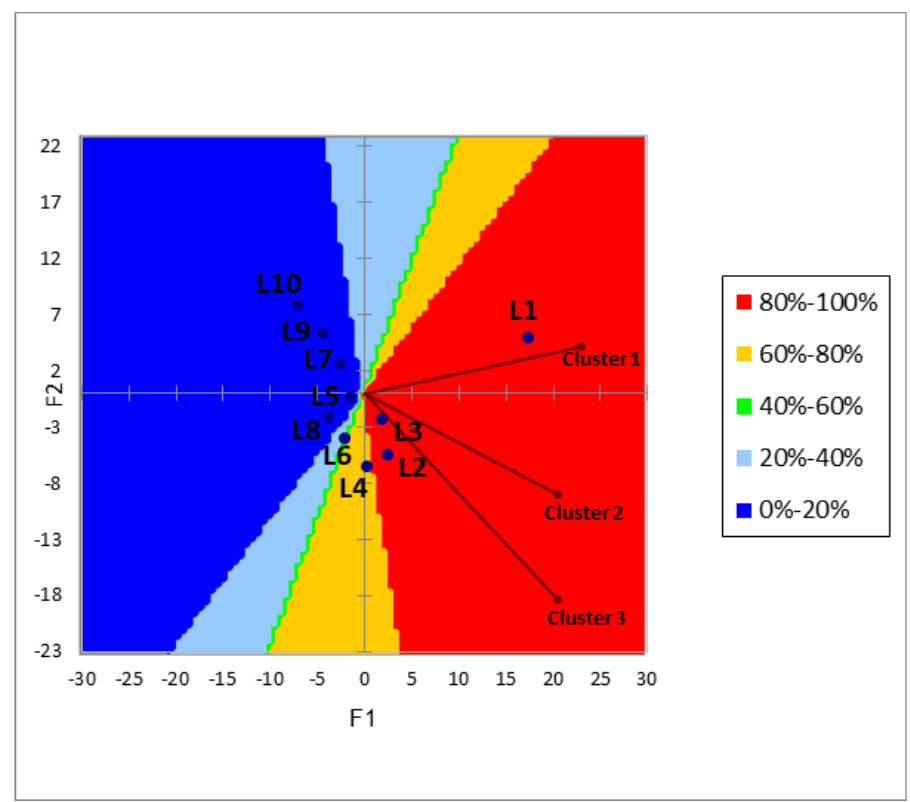
Figure 5. Preference map of consumers clusters and contour plot of preference for yogurt labels (Blue points): L1 (Orange color label with sweeteners), L2 (White color label with sweeteners), L3 (Yellow color label with sweeteners), L4 (Blue color label with sweeteners), L5 (Green color label with sweeteners), L6 (Orange color label with sucrose), L7 (White color label with sucrose), L8 (Yellow color label with sucrose), L9 (Blue color label with sucrose) and L10 (Green color label with sucrose).